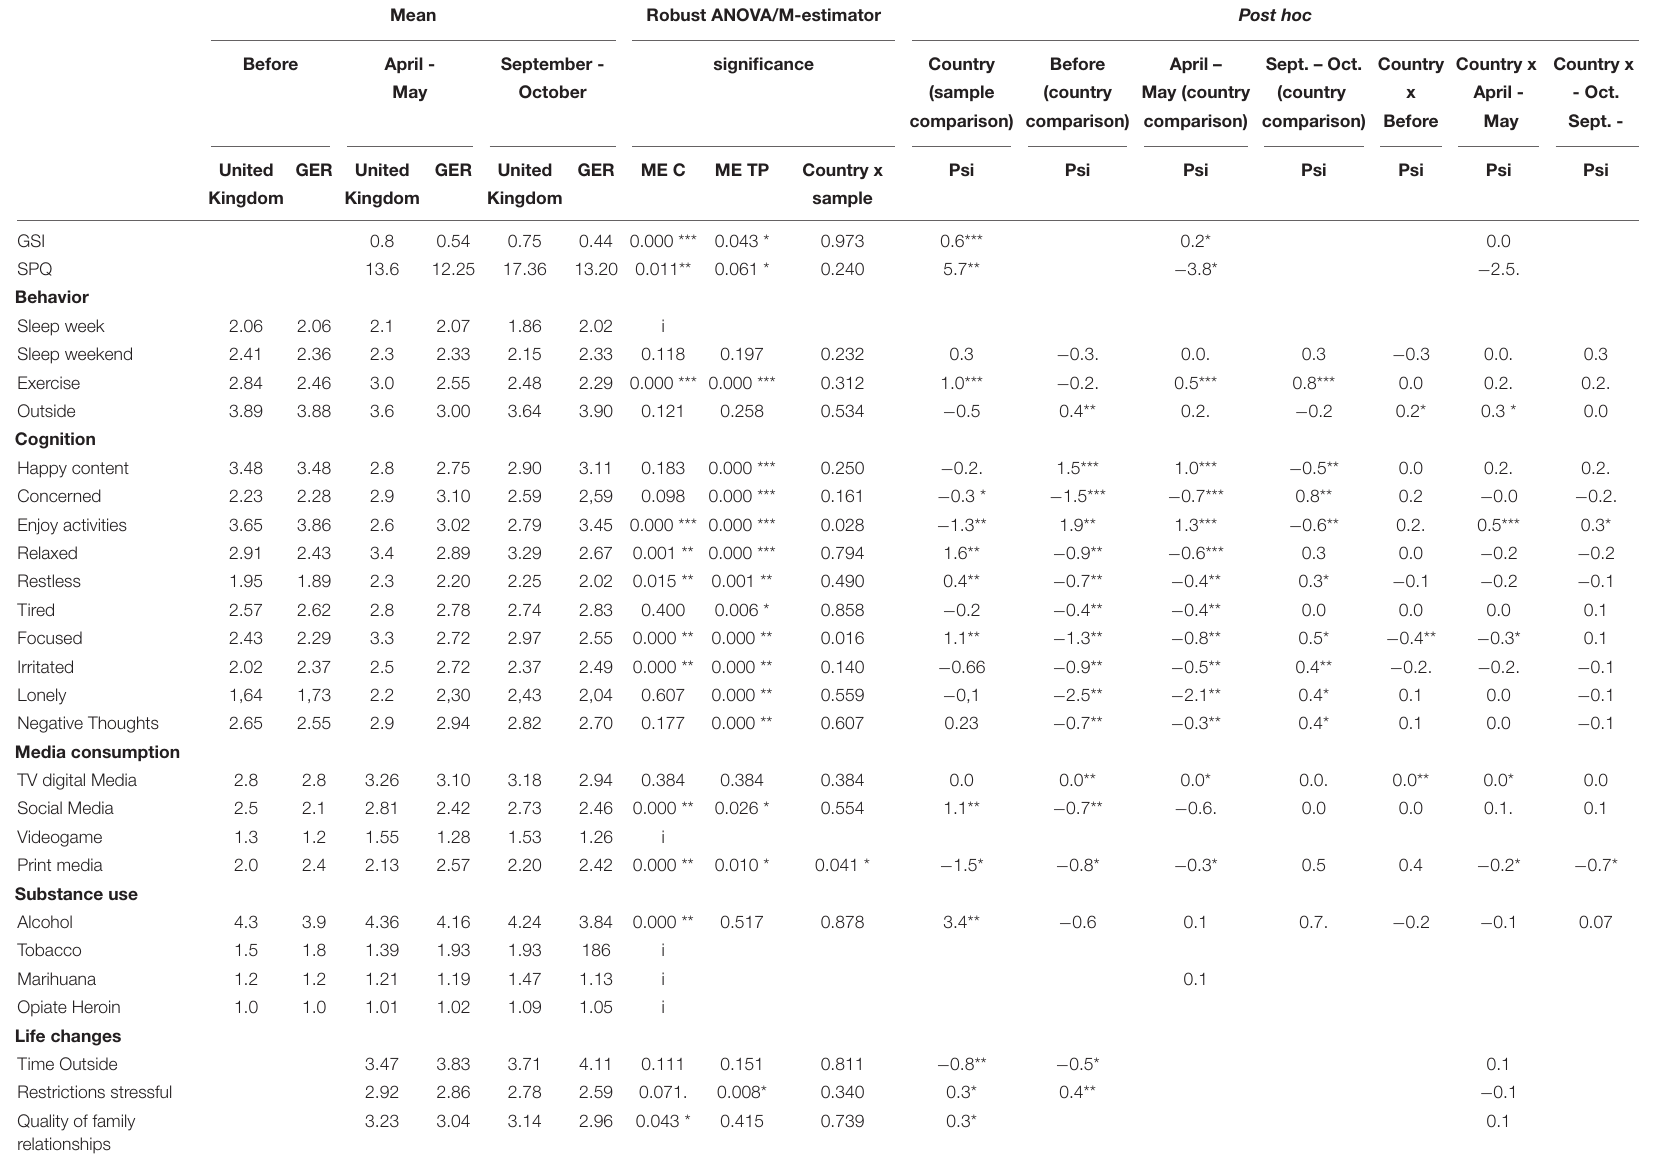
TABLE 2 | Overview of means and robust ANOVAS of GSI and SPQ scores, all CRISIS variables and questions concerning life changes due to